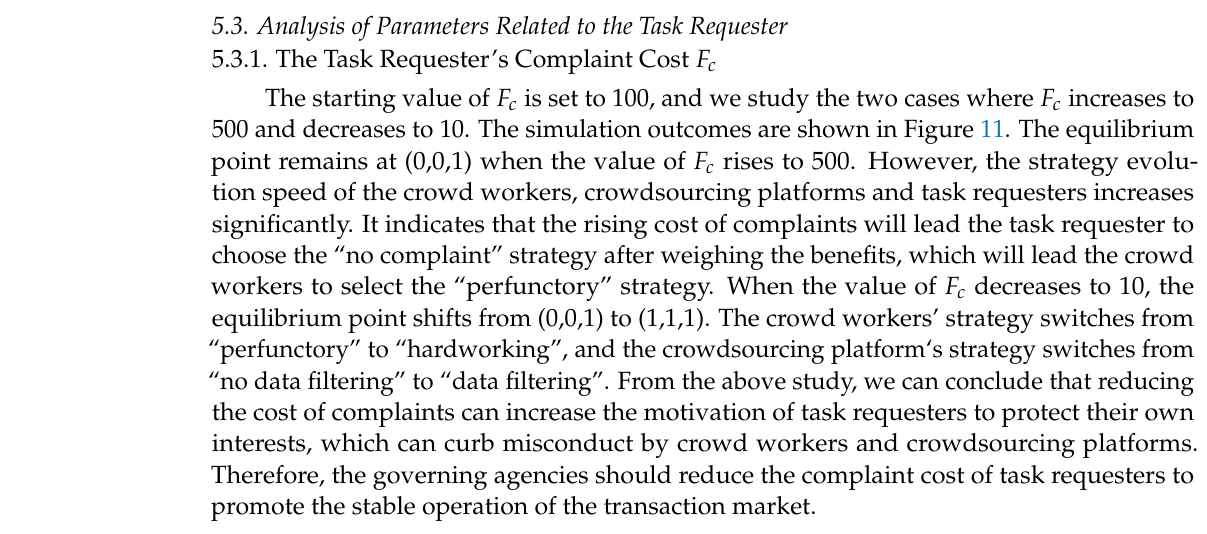
Figure 10. The impact of α on evolution: ( a ) crowd workers; ( b ) crowdsourcing platforms; ( c ) task requesters.